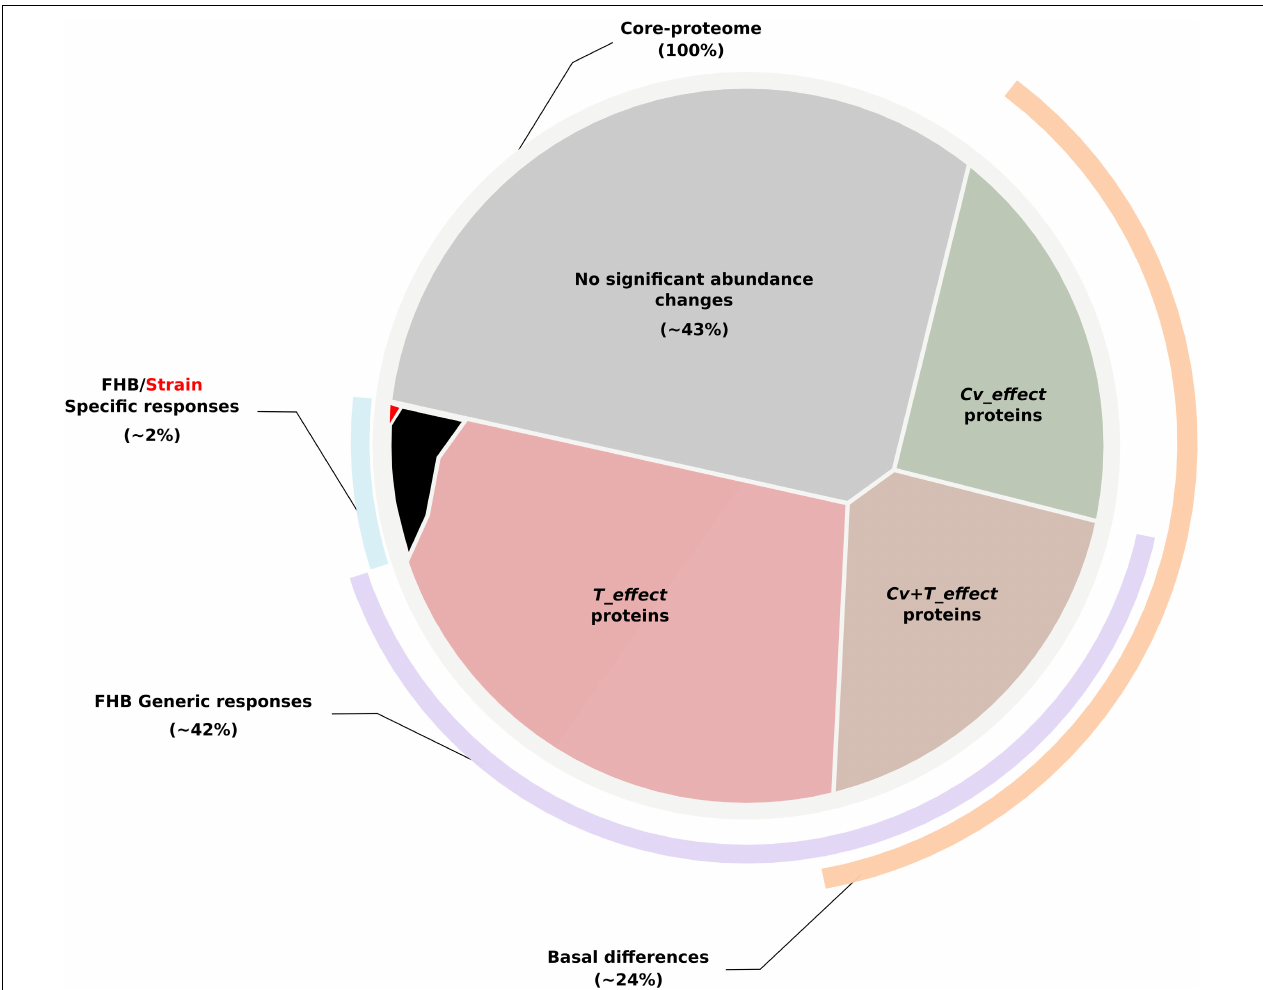
FIGURE 3 | Voronoï representation of the wheat core proteome from the protein abundance patterns. The circular plane, depicting all identified proteins belonging to the core proteome, is partitioned into regions illustrating the proportion of (i) proteins with no significant abundance change according to the factors tested in the ANOVA (in gray ); (ii) proteins whose abundance differences were only explained by the wheat genetic background (i.e., Cv_effect proteins depicted in green ); (iii) proteins whose abundance differences were specifically explained by the presence of Fusarium graminearum stricto sensu (i.e., T_effect proteins depicted in light red ); (iv) proteins displaying significant abundance variations during the infection while maintaining the baseline differences discriminating the three wheat cultivars in the control condition (i.e., Cv + T_effect proteins depicted in brown ); and (v) proteins harboring significant abundance variations allowing to distinguish the different wheat cultivars in their response to the disease (i.e., Cv × T_effect proteins, in black ) or to a particular F. graminearum strain ( Cv × T{S}_effect proteins, in red ). According to such categorization, lines outside the circle show the core proteome proportions corresponding to the basal differences between the three cultivars (in orange ), the wheat generic responses to the disease (in purple ), and the wheat genetic-dependent responses to FHB (in blue